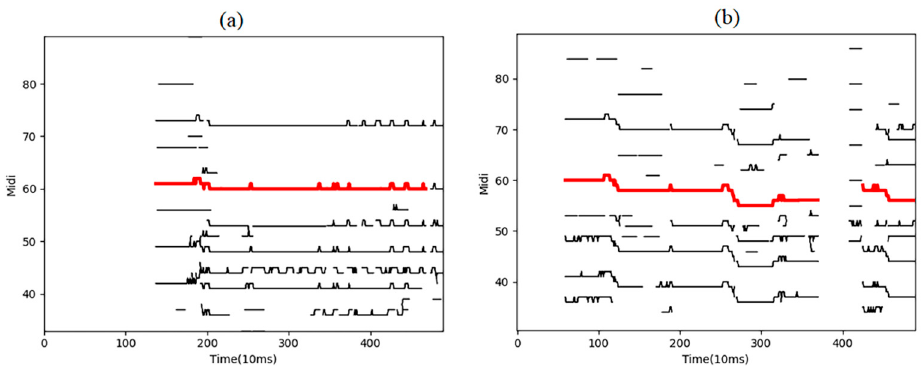
Figure 2. Red lines represent the contours of the human voice, while black lines represent the contours of interference: ( a ) ADC04.daisy01.wav, ( b ) ADC04.daisy02.wav.